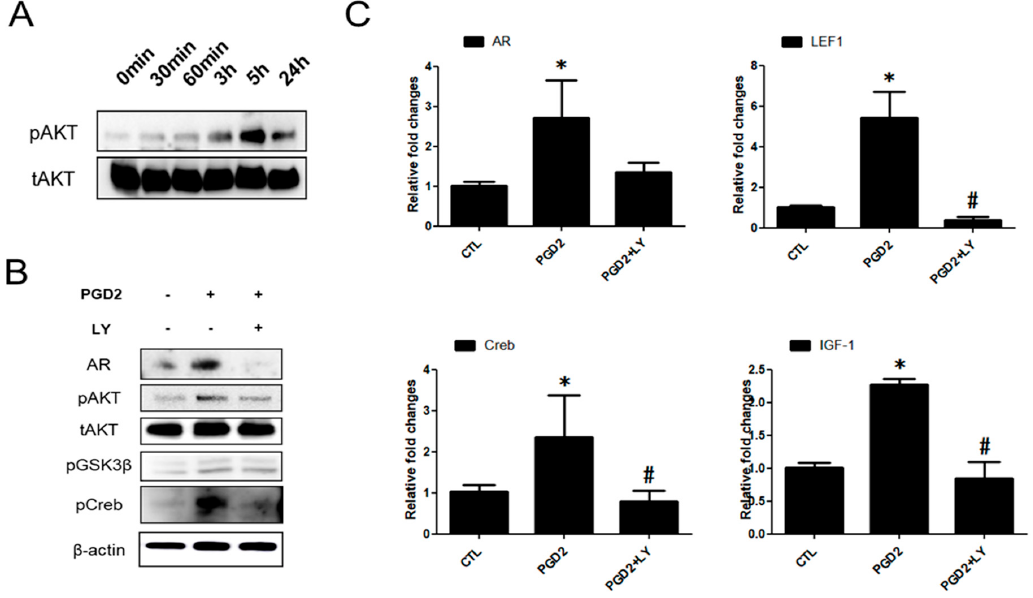
Figure 3. PGD2 regulates the AKT signal. The AKT phosphorylation was determined using western blot analysis. hDPCs were treated with PGD2 (200 nM) for the indicated times and harvested ( A ). hDPCs were pretreated with LY294002 for 1 h, and then PGD2 (200 nM) treatment for 5 h. The protein levels of AR, and AKT/GSK3 β /Creb phosphorylation was measured using western blot analysis ( B ). The mRNA expression of AR, LEF1, Creb, and IGF-1 was measured using qRT-PCR ( C ). β -actin served as a loading control for protein normalization. GAPDH was used as an internal control for mRNA normalization. The results are expressed as the mean ± SD of three independent experiments. * p < 0.05, compared with the control (0 nM PGD2), # p < 0.05 compared with PGD2.